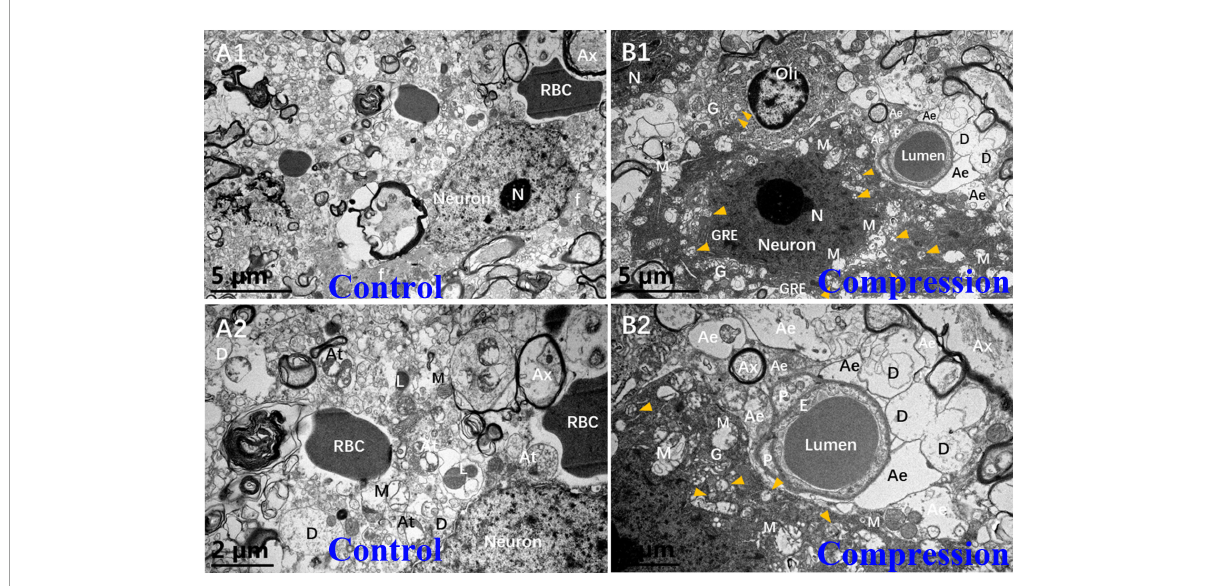
FIGURE5 Comparison of ultrastructural evidence of neuron, NVU degeneration, and apoptosis between samples from the control group (A1,A2) and CSM group (B1,B2)